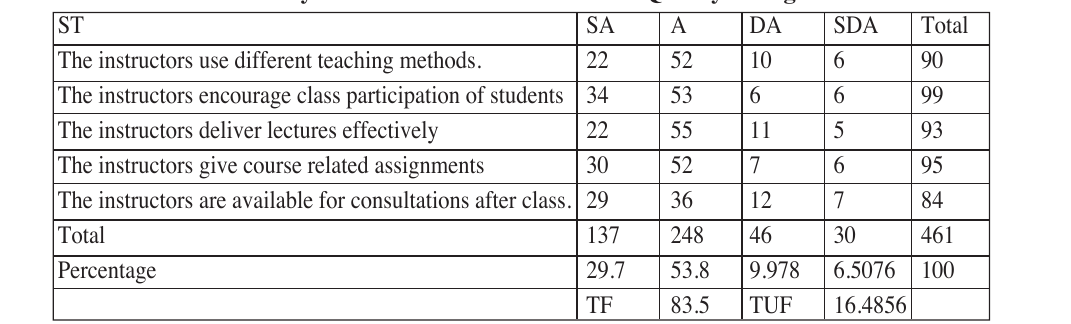
Table No. 4: Faculty Contribution To maintain the Quality in Higher Education